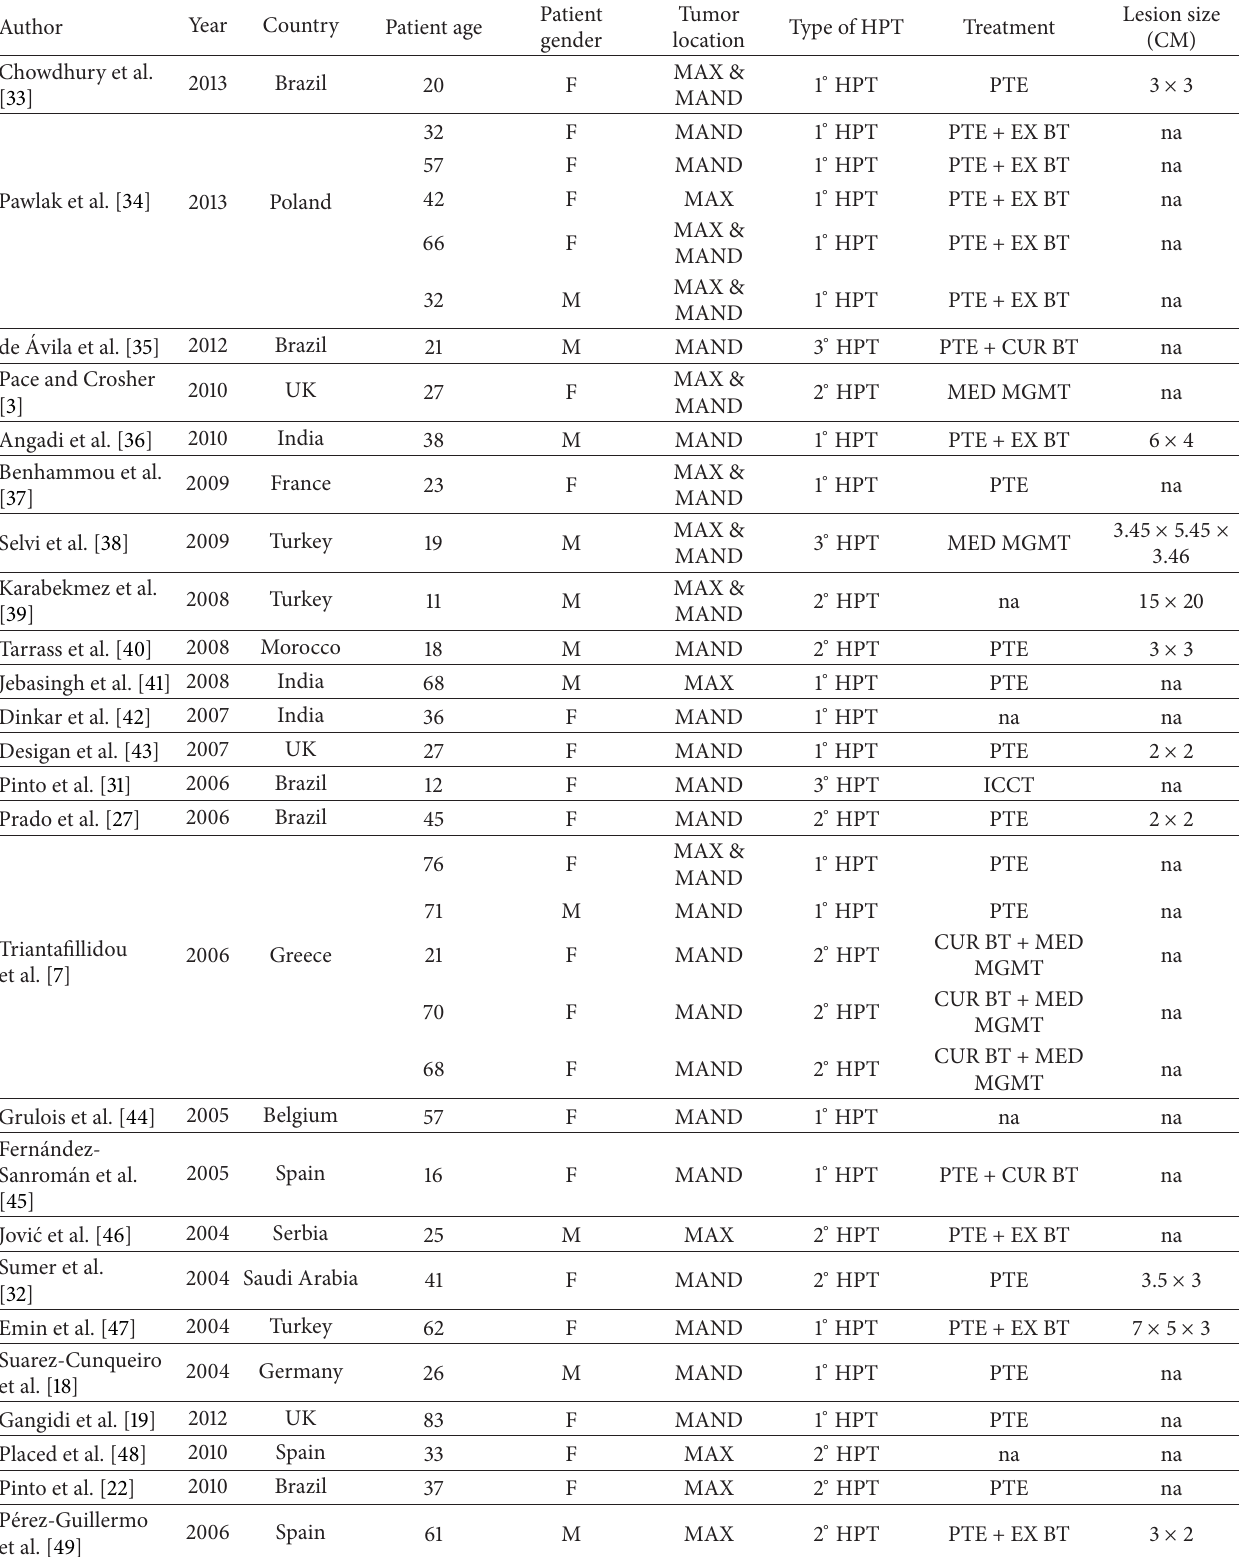
Table 1: Summary of cases of brown tumor of hyperparathyroidism in the